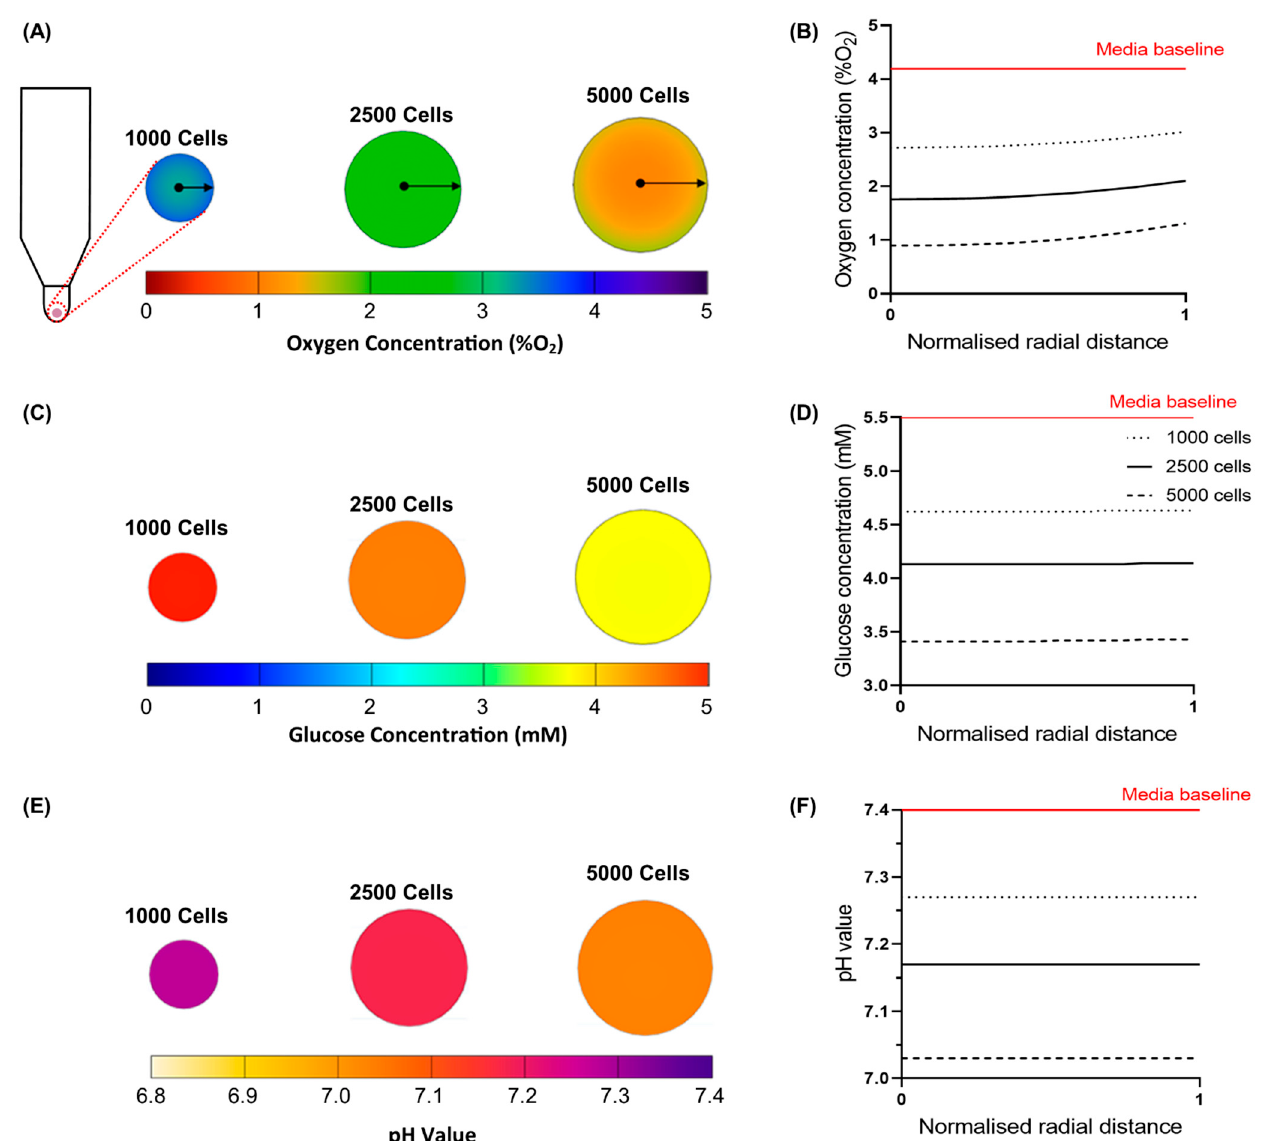
Figure 4. In silico modelling of the nutrient microenvironment within microtissues as a function of cell density. Predicted contour plots and radial profile through the midplane containing 1000, 2500 and 5000 cells for ( A , B ) oxygen (%O 2 ) ( C , D ) glucose (mM) and ( E , F ) pH. The radial distance was normalised by the radius of the microtissue for each cell density.